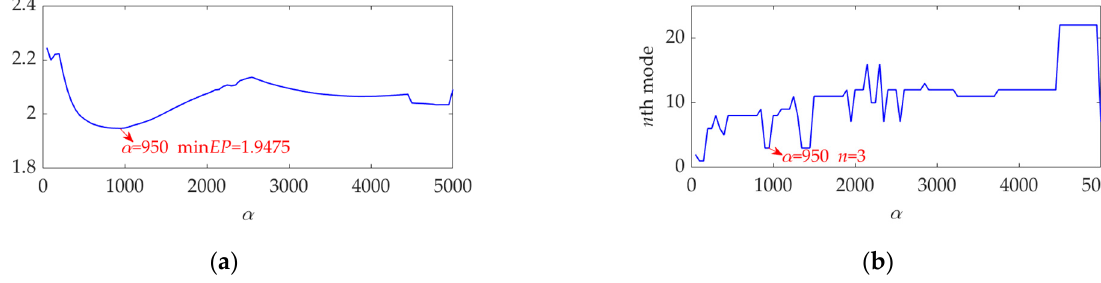
Figure 4. Relationship between the α value and ( a ) the EP index value and ( b ) order number of the target mode in each step of α increase.